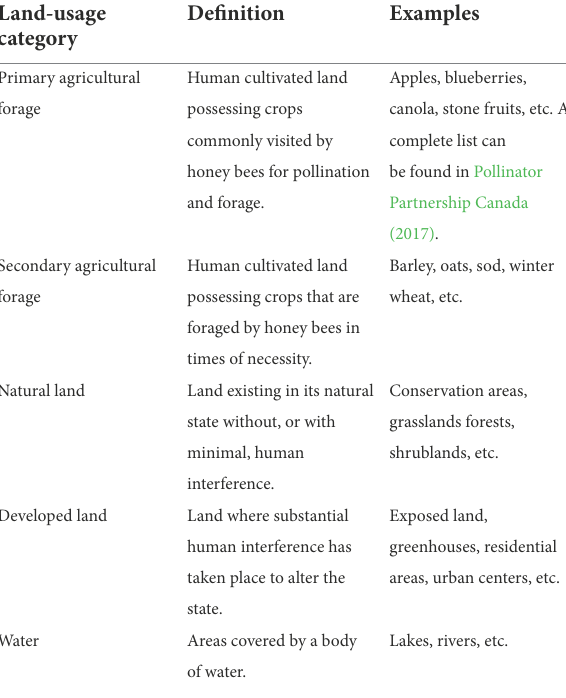
TABLE 1 Definitions and examples of the five land-usage categories